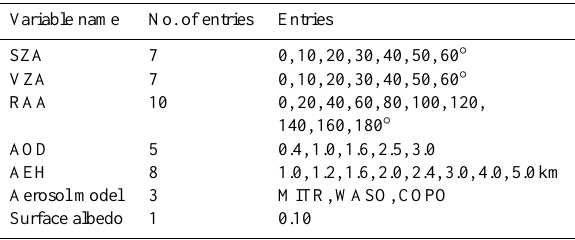
Table 3. Dimensions of simulation cases for the error analysis of the AEH